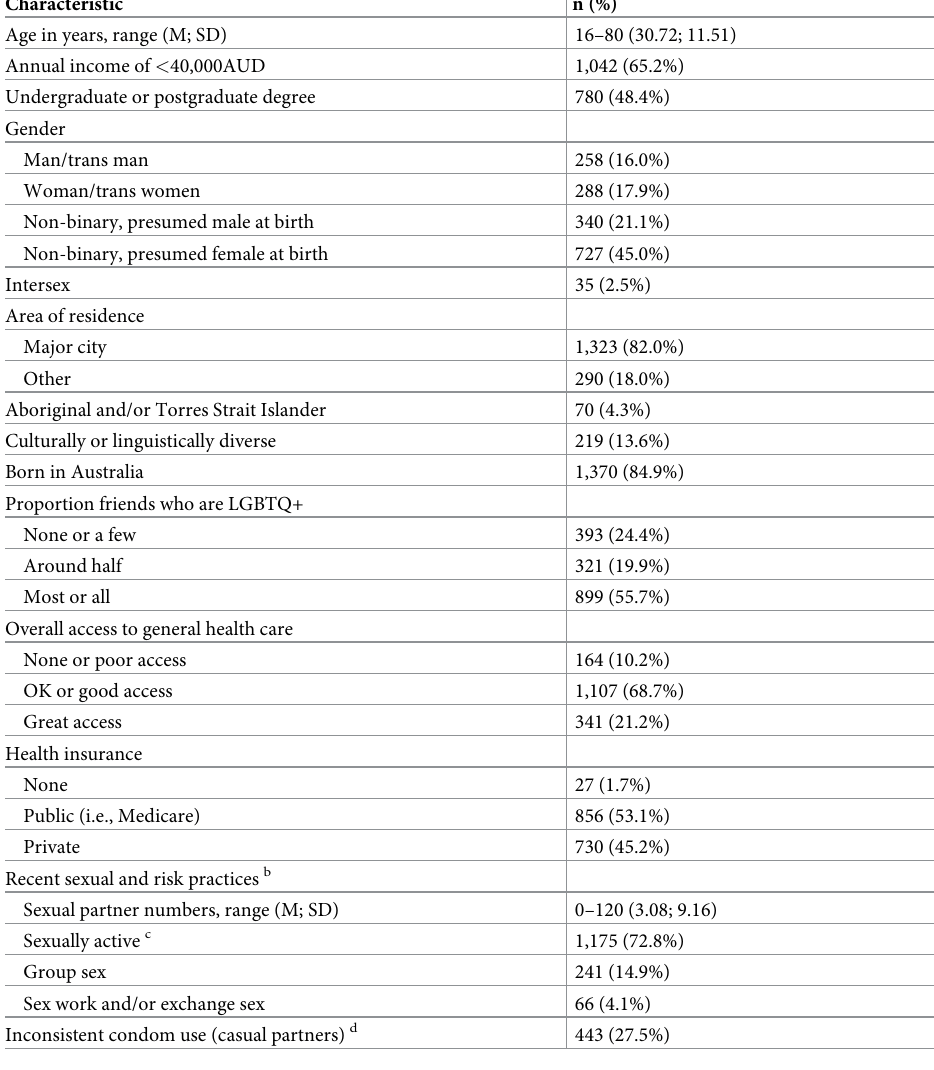
Table 2. Sociodemographic, social network, and sexual practice characteristics among a sample of trans and gen- der diverse people in Australia (n = 1,613) a . Characteristic n (%) Age in years, range (M;